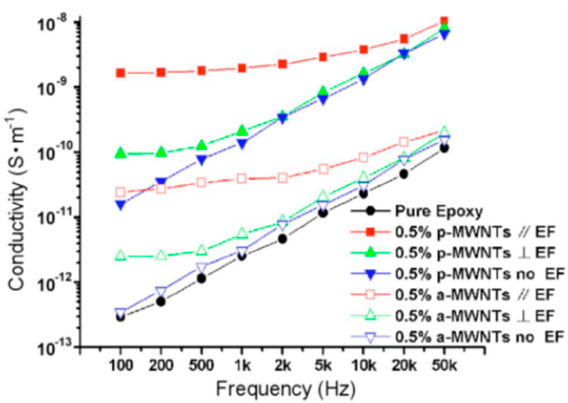
Figure 22. Electric conductivities of pure epoxy and nanocomposite samples containing MWNTs [71].